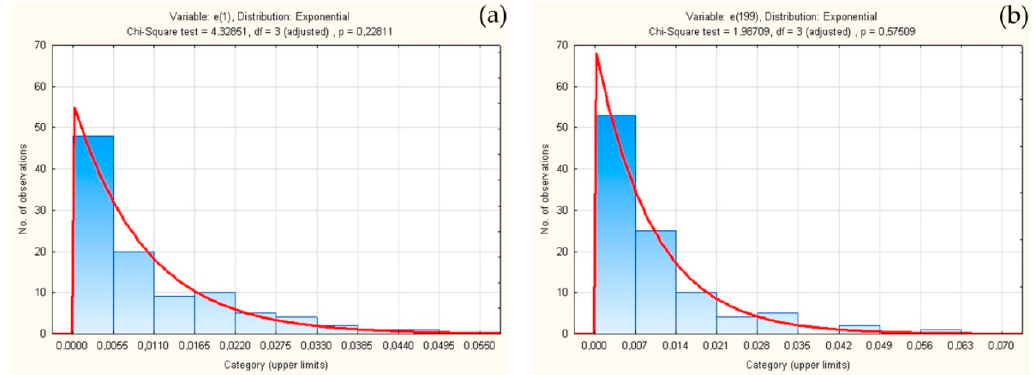
Figure 3. Verifications of exponential distributions for sets Δ↓ [e(1)] ( a ) and Δ↓ [e(199)] ( b ).